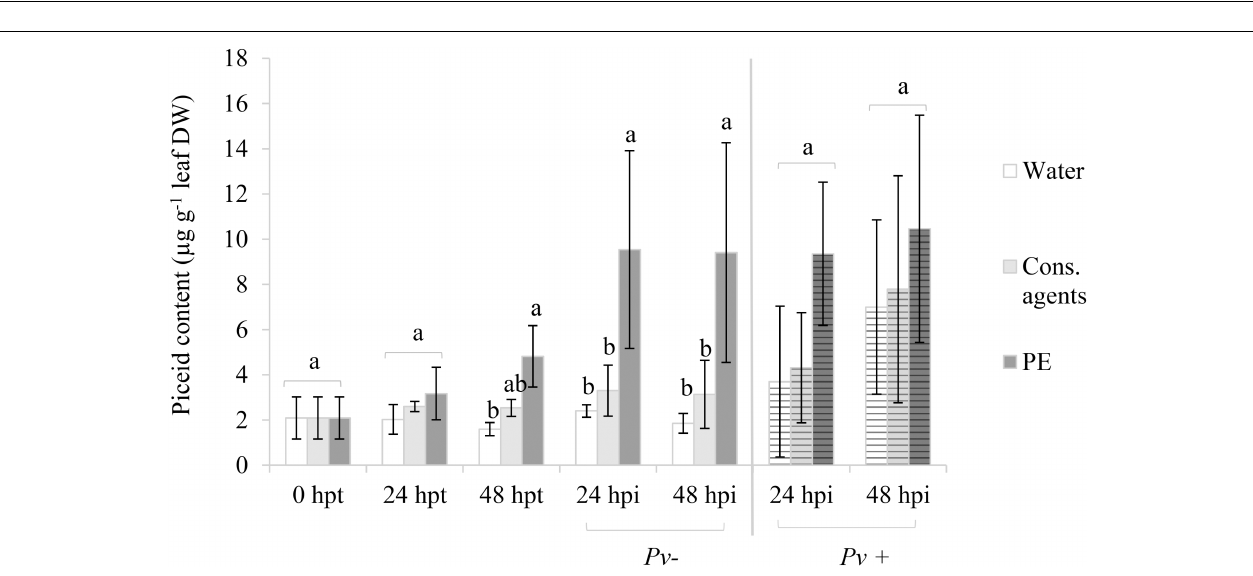
FIGURE 5 | Relative expression of defense-related genes in PE-treated grapevine leaves. Plants were treated with PE (5 g L − 1 ), equal volumes of cons. agents or water and leaves were collected at 24 and 48 hpt. Six genes encoding a (A) pathogenesis-related protein 1 (PR1); (B) β -1.3 glucanase (PR2); (C) chitinase 4c (PR3); (D) phenylalanine ammonia-lyase 1 (PAL); (E) stilbene synthase (STS); (F) lipoxygenase 9 (9-LOX); and (G) lipoxygenase 13 (13-LOX) were investigated by qRT-PCR. Results represent relative fold expression calculated with the 2 − (cid:49)(cid:49) Ct method, compared to the housekeeping gene EF1 γ and to water control for each respective time point. Data represent mean from three technical replicates of one representative biological repetition.